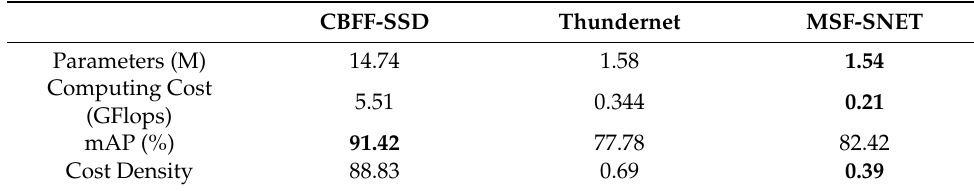
Table 4. Cost comparison of different algorithms.